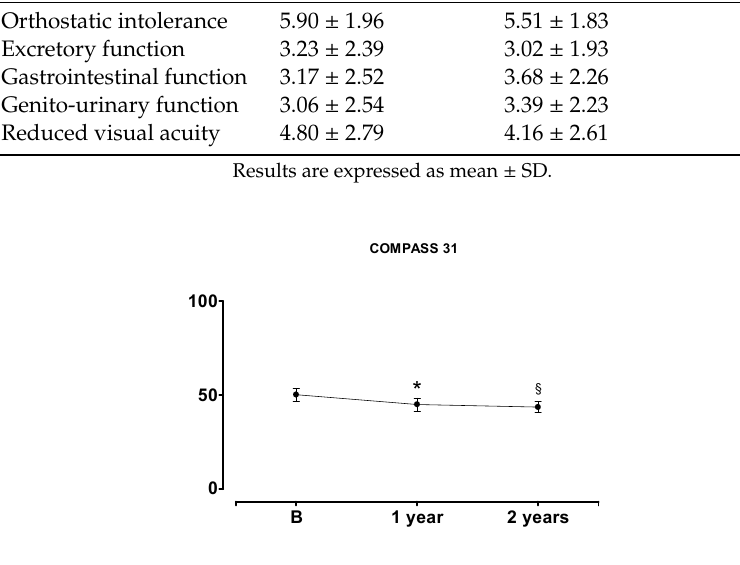
Figure 5. COMPASS 31 total score comparison between baseline and 1-year and 2-year follow-up. B indicates baseline. * indicates p < 0.05 12 months vs. baseline; § indicates p < 0.05 24 months vs. baseline. Results are expressed as mean ± SD. Table 7. COMPASS 31 autonomic symptom assessment comparison between baseline and 1-year and 2-year follow-up.